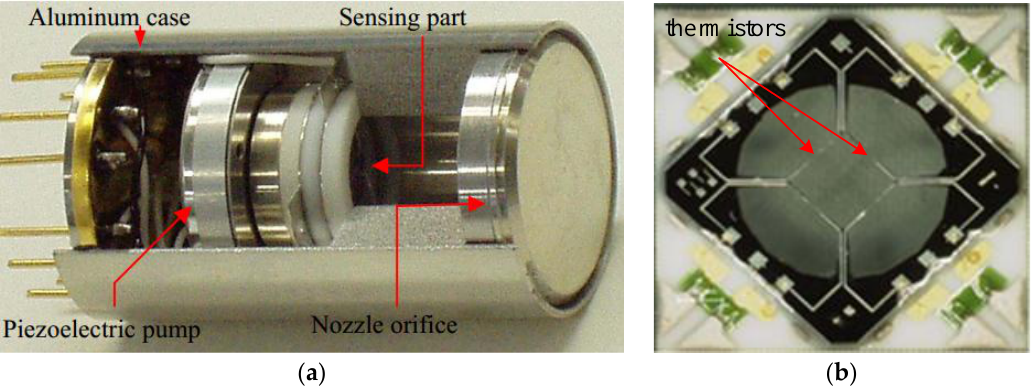
Figure 8. ( a ) Cut view of the dual-axis micromachined jet flow gyroscope; ( b ) micro graph of the sensing element [64]. sensing element